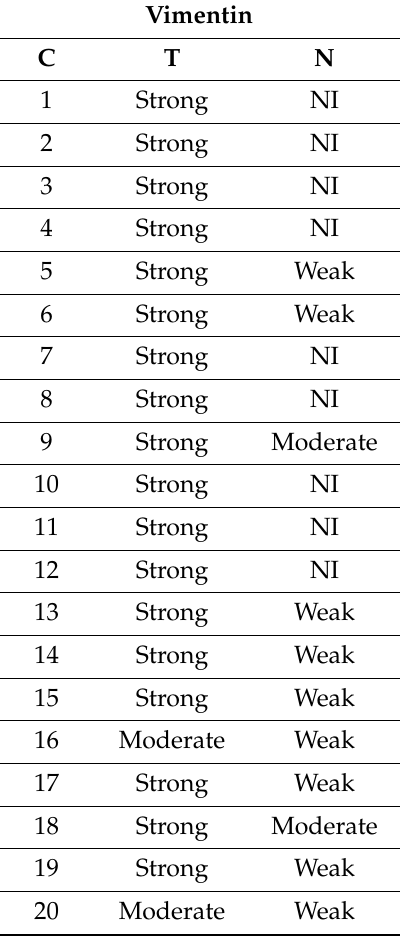
Table 3. Immunohistochemical detection of vimentin proteins in human cervical cancer tissues.